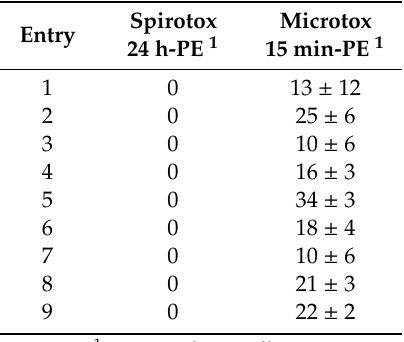
Table 3. The cytotoxicity results of the synthesized copolymers.